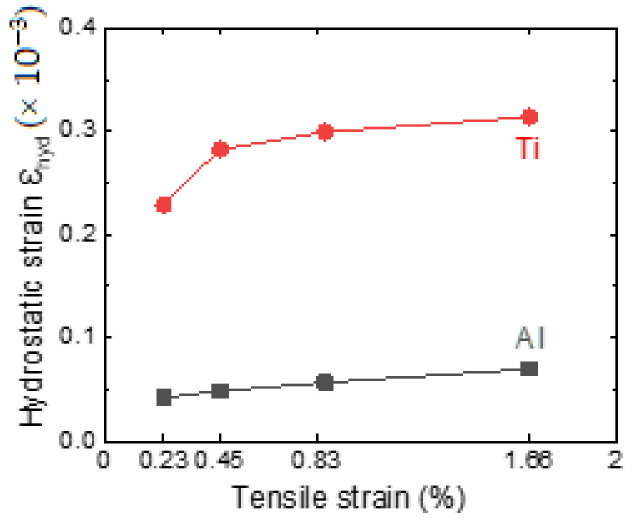
Figure 15. Estimated average hydrostatic strains ε hyd for Ti and Al during tensile loading. The 0.2% offset yield point strains for Ti and Al are about 0.45% and 0.23%,